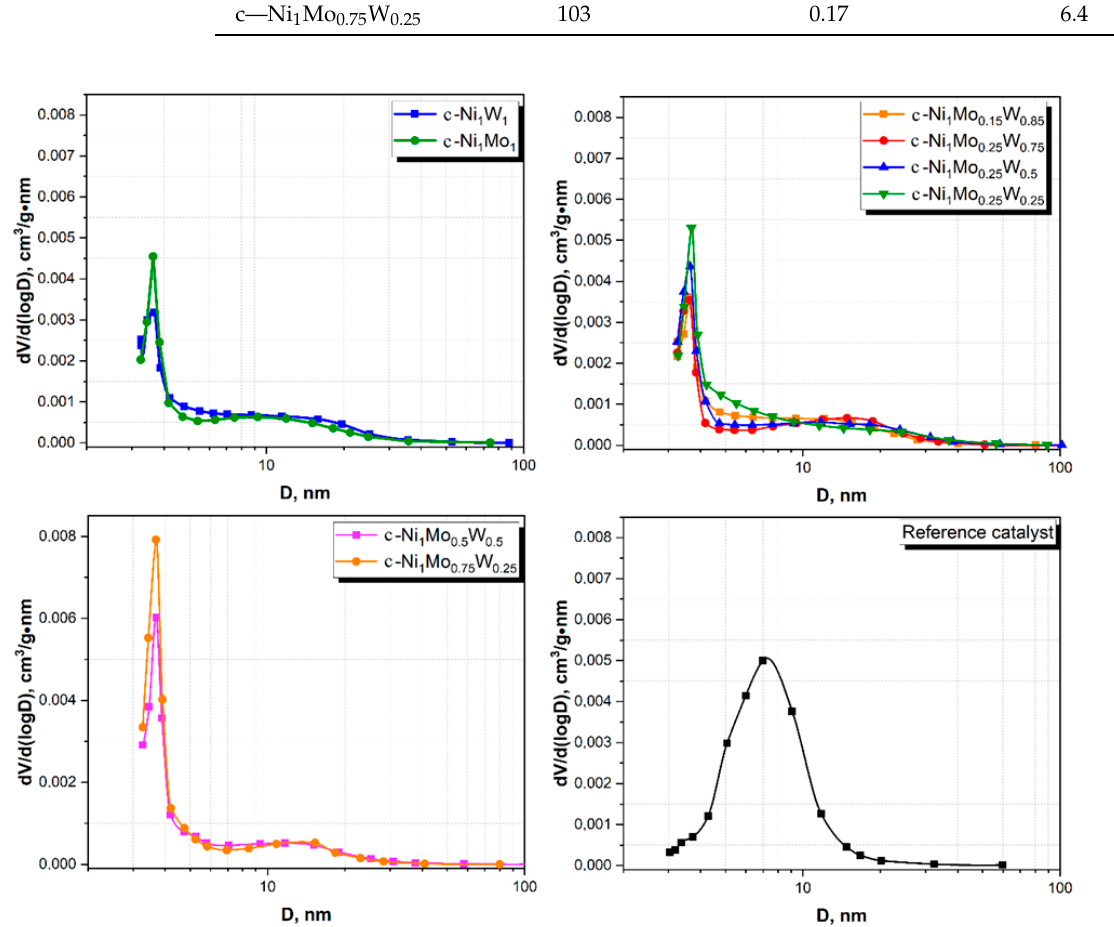
Figure 3. Pore size distribution curves for bulk c—Ni 1 Mo 1 , c—Ni 1 W 1 , and c—Ni 1 Mo x W y catalysts.